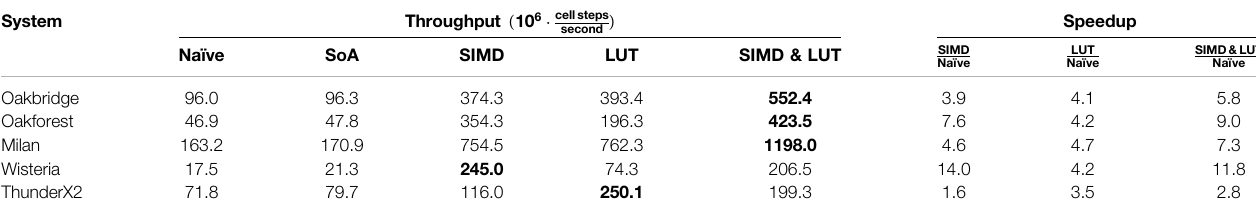
TABLE 10 | Multi-threaded performance of naïve, auto-vectorised and LUT implementations for the TP06 model in a simulation scenario. The Rush – Larsen scheme is used with Δ t = 0.1µs, C = 11688851 cells. “ SoA ” refers to the “ struct of arrays ” memory layout discussed in Section 2.3.2 . The most performant implementation is in